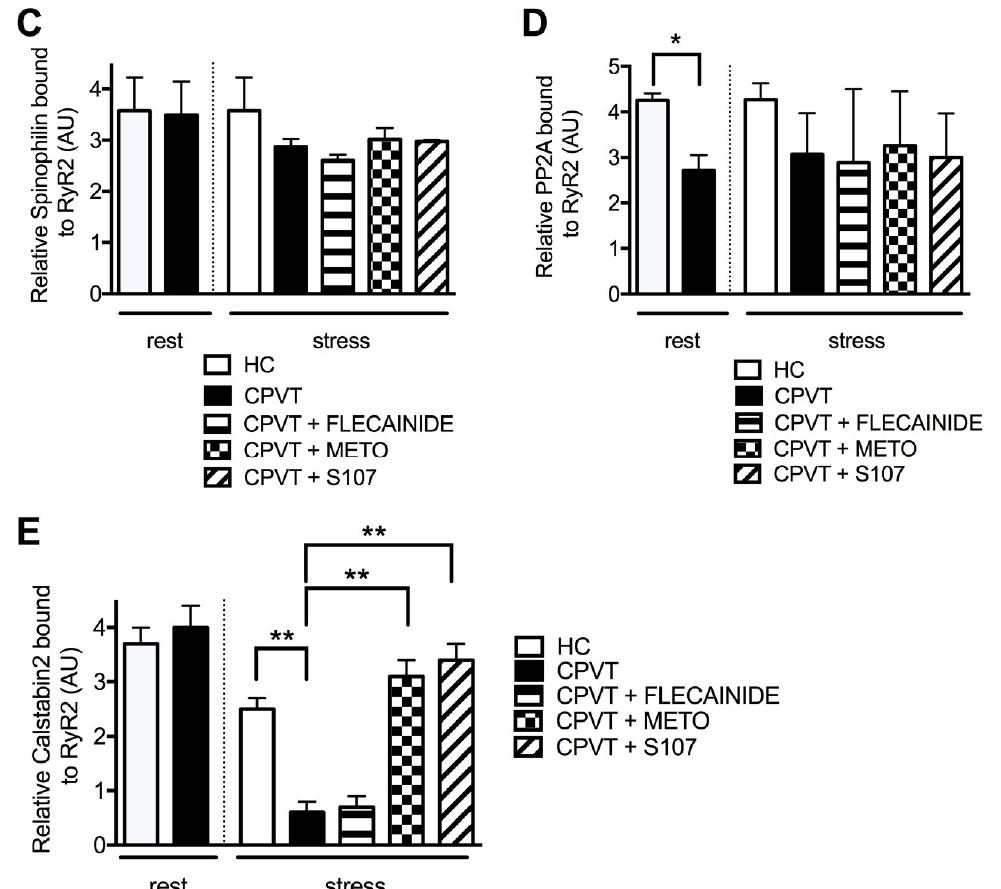
Figure 7. PKA-phosphorylated CPVT RyR2-D3638A mutant channels are depleted in Calstabin2 which is prevented by S107 but not by flecainide. ( A ) Representative immunoblot bands of HC and CPVT lysates (c2.2) at rest and under stress (1 µ M ISO application) for total RyR2, PKA-phosphorylated RyR2 at S2809 site, spinophilin, PP2A and Calstabin2. In stress conditions, CPVT cells were also either pretreated with 5 µ M flecainide (FLEC.), or 5 µ M metoprolol (METO) or 5 µ M S107 ( B – E ) Bar graphs showing data normalization from immunoblots for the relative RyR2 PKA phosphorylation, spinophilin, PP2A and Calstabin2 bound to RyR2 in HC and CPVT at rest and under stress and in presence of flecainide, METO and S107. For each condition, n = 3 to 8 independent experiments. * p < 0.05; ** p < 0.01.